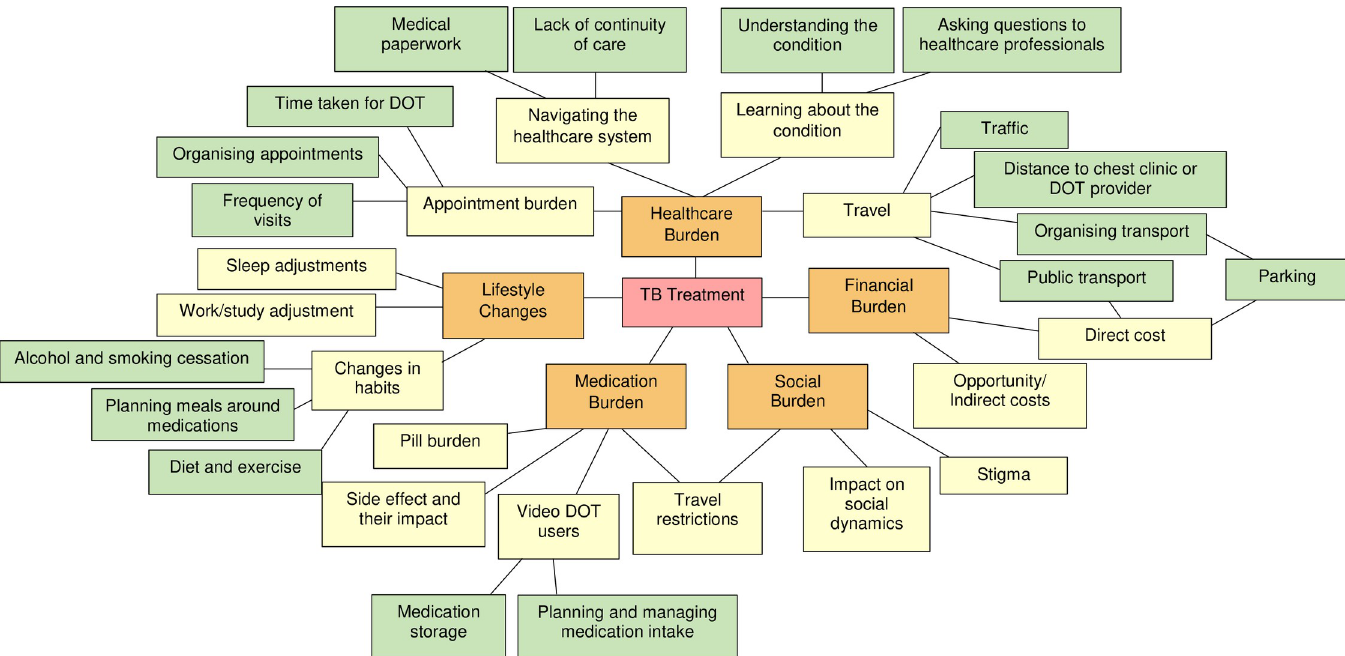
Fig 1. Treatment burden framework for tuberculosis. Red: main theme; orange: main categories of treatment burden; yellow: sub-themes; green: specific forms of treatment burden.